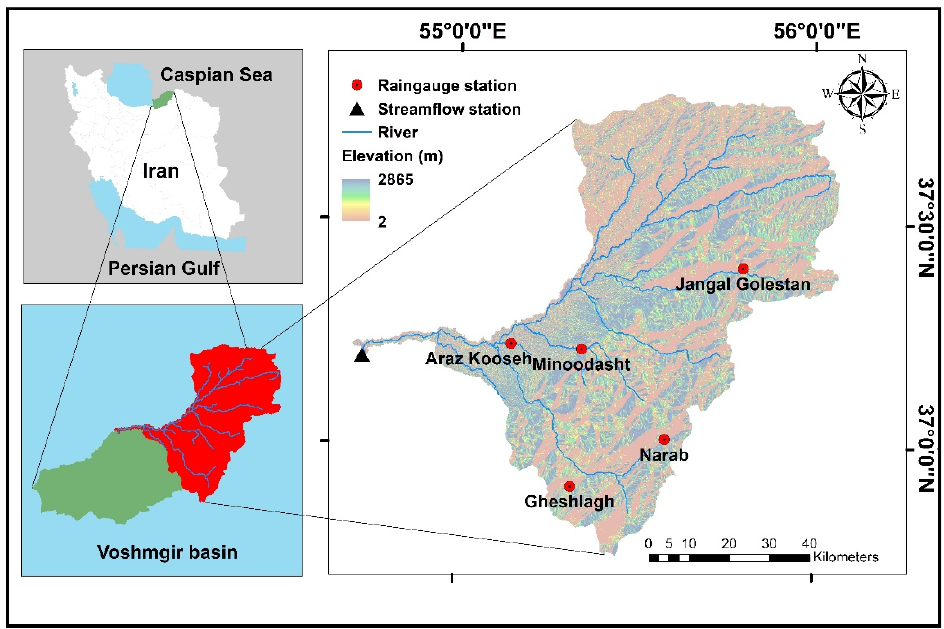
Figure 1. Study area with gauge stations in the Voshmgir basin, Iran.